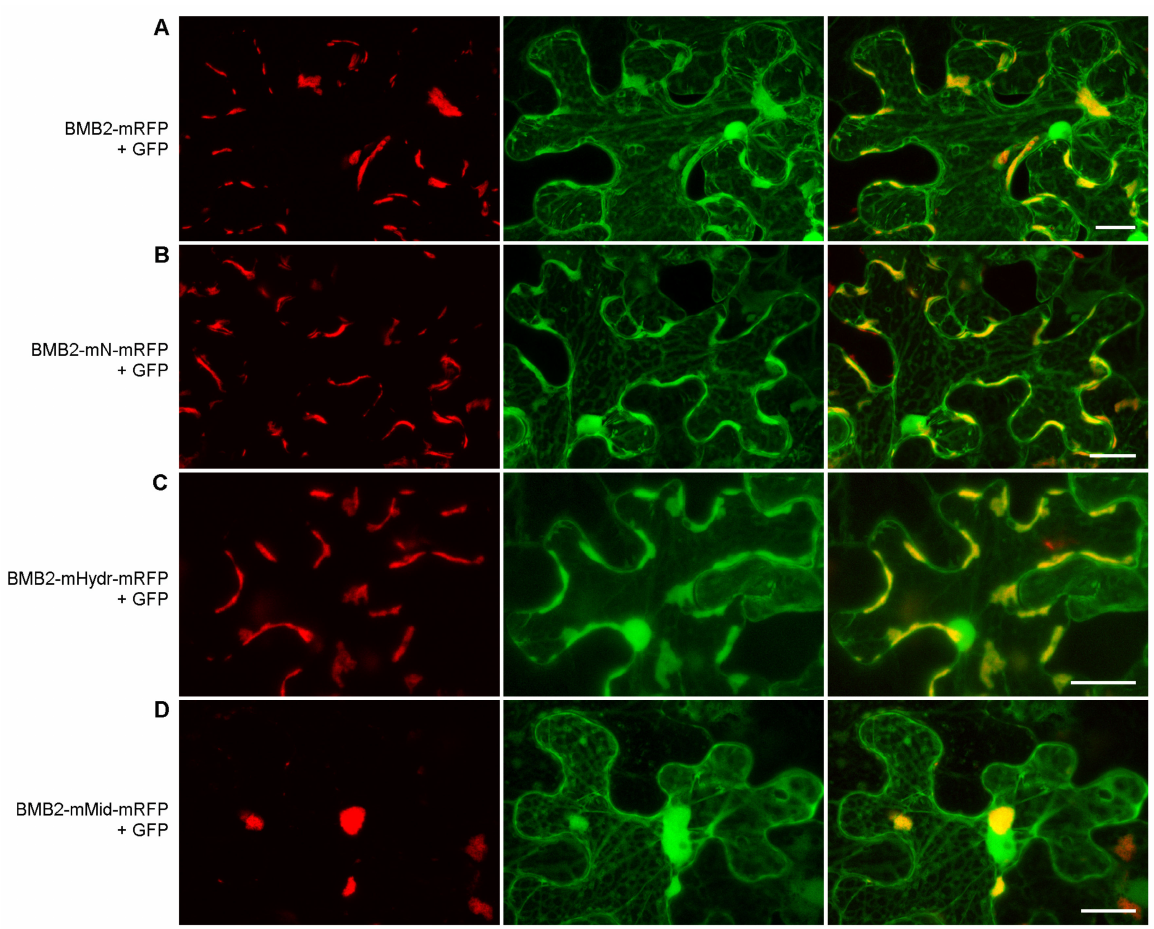
Figure 5. Subcellular localization of BMB2 mutants BMB2-mN ( B ), BMB2-mHydr ( C ) and BMB2- mMid ( D ). The mutants and the wild type protein ( A ) taken as a control were coexpressed with GFP to visualize cells. Left images, mRFP channel. Center images, GFP channel. Right images, superposition of images for GFP and mRFP channels. All images are reconstructed from Z-series of optical sections. Scale bar, 20 µ m.